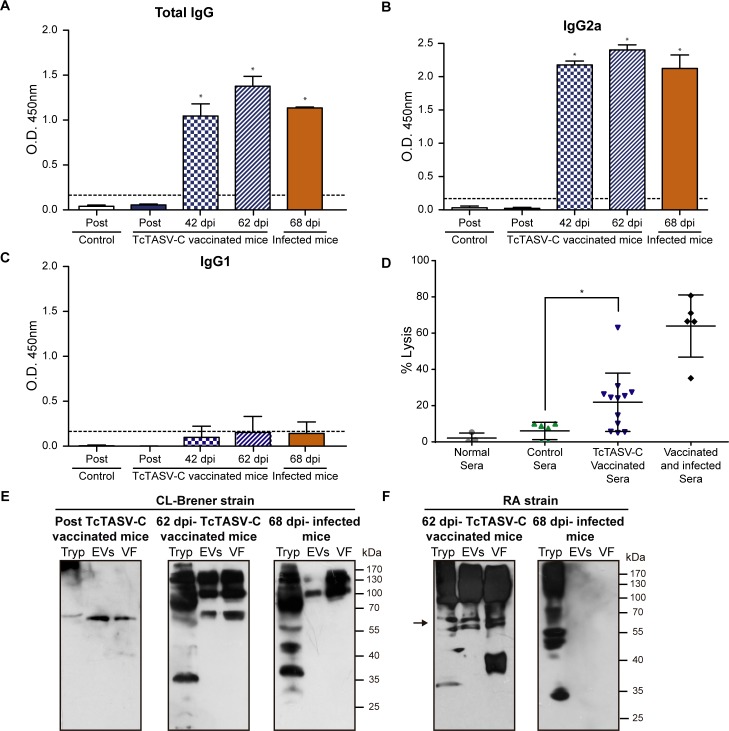
Humoral anti-T. cruzi response after vaccination and after T. cruzi challenge.Serum samples were obtained before the first (Pre), 15 days after the last dose (Post) of immunization and at 42 and 62 dpi. A pool of sera from chronically infected (non-vaccinated) mice was also evaluated (68 dpi infected mice, spontaneous survivors from infection with 100 RA trypomastigotes by the intradermal plantar route). (A) Total IgG, (B) IgG2a and (C) IgG1 antibodies against total T. cruzi antigens were determined by ELISA. Dotted line indicates the cut-off value. (D) Complement-mediated lysis of T. cruzi trypomastigotes. Parasites (500000/assay) were incubated with inactivated sera from preimmune (Normal sera), GST-vaccinated (Control group), TcTASV-C vaccinated or vaccinated and surviving mice for 1 h at 37°C, followed by treatment with fresh human complement (1:4) or inactivated human complement for an additional 1 h at 37°C. Trypomastigote lysis was calculated by counting living, motile and unstained parasites in a Neubauer chamber after staining with Trypan blue. Each dot represents 2–3 pooled sera, assayed together. (E) and (F) Western blot of trypomastigote lysate (Tryp), EVs and EV-free supernatant fraction (VF) from CL-Brener (E) or RA (F). Proteins were probed with immune sera from vaccinated mice (Post TcTASV-C vaccinated mice), sera from surviving vaccinated mice (62 dpi-TcTASV-C vaccinated mice) and RA-infected (unvaccinated) mice (68 dpi-Infected mice). *p<0.05 when pairwise compared to Control group by One-way ANOVA.